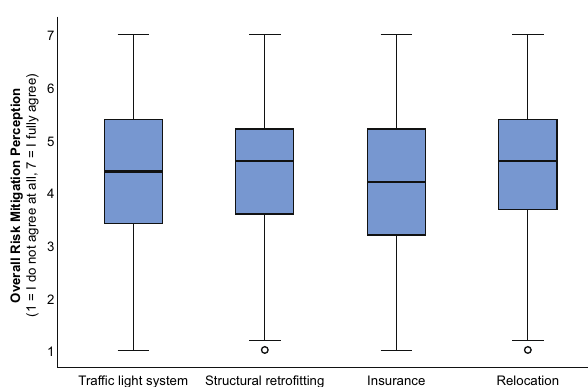
Fig. 1 Overall perception of risk mitigation measures (average of the four categories effectiveness, necessity, safety, and technology approval, N = 807)